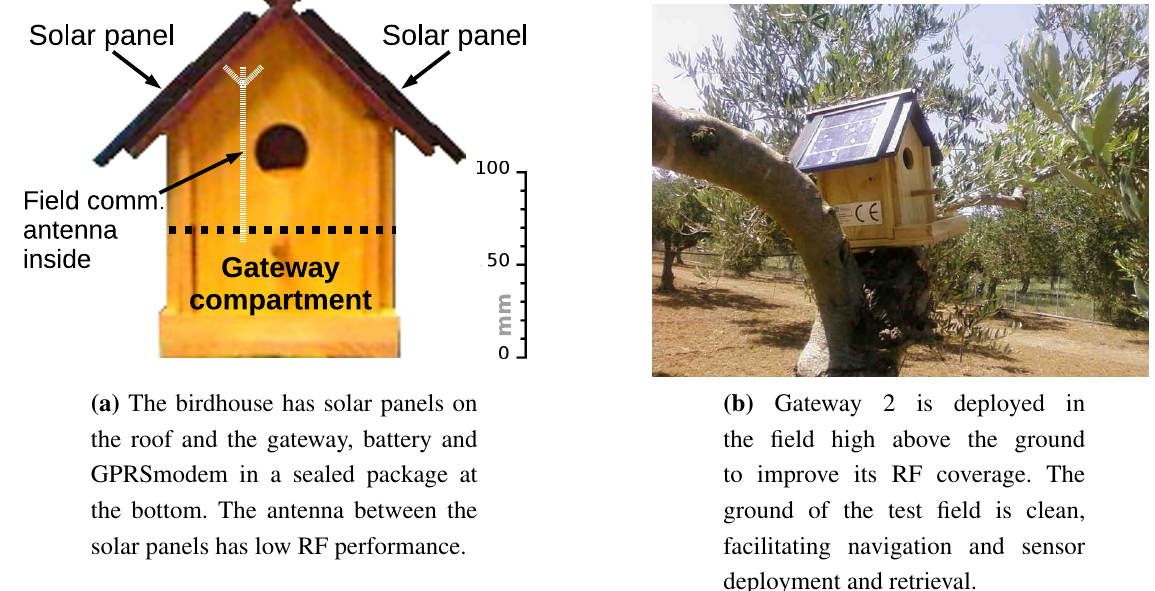
Figure 9. Gateway package elements ( a ) and field placement of Gateway 2 ( b ).